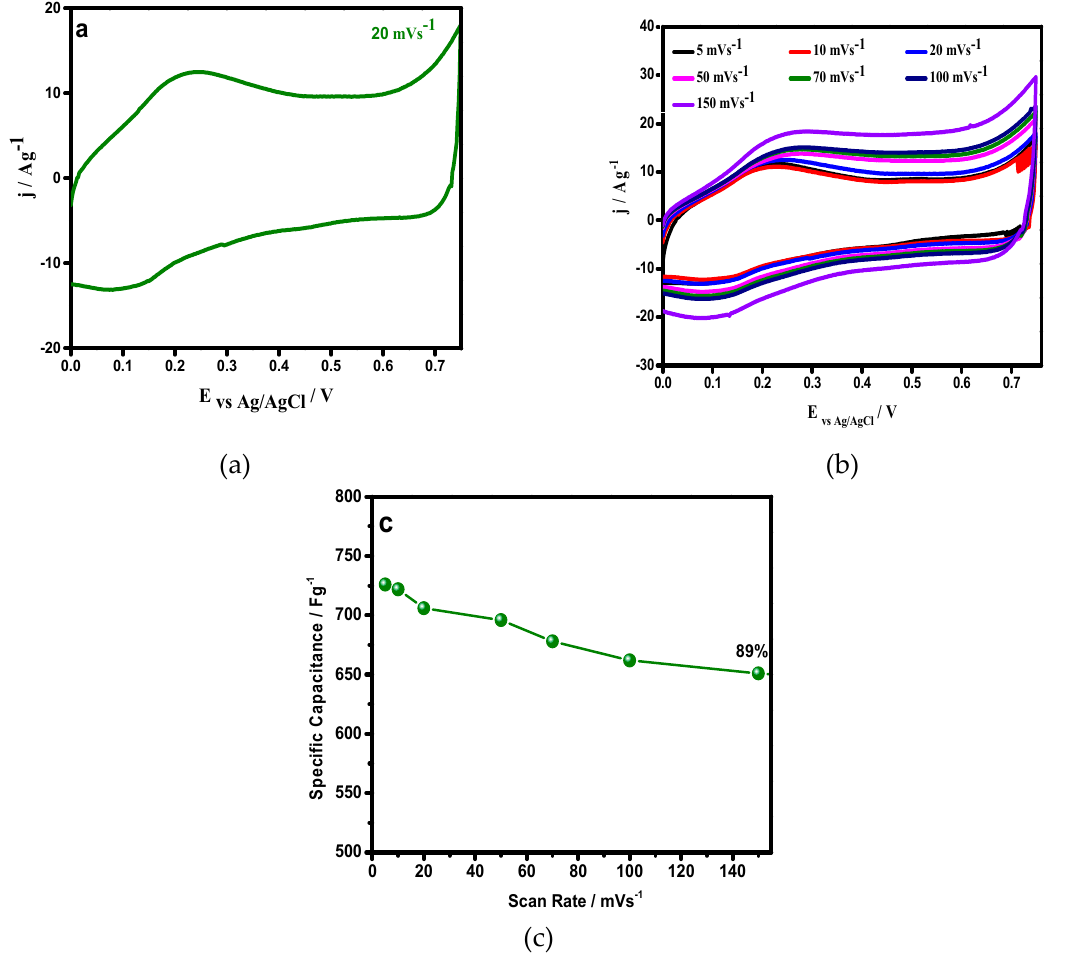
Figure 5. Cyclic Voltammograms (CVs) of the recorded PANI–DBSA ( a ) at 20 mV/s. ( b ) In a scan range of 5–150 mVs − 1 , as indicated, and ( c ) capacitance retention of PANI–DBSA as a function of the scan rate.